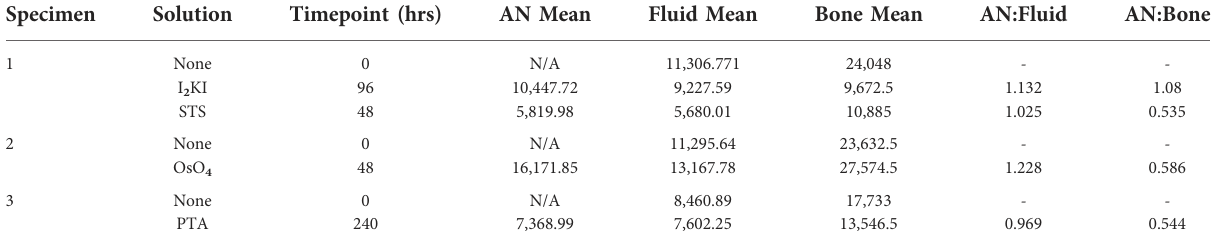
TABLE 2 Comparison of gray scale values for auditory nerve, fl uid fi lled spaces, and bone at optimal time points for each solution. Specimen Solution Timepoint (hrs) AN Mean Fluid Mean Bone Mean AN:Fluid